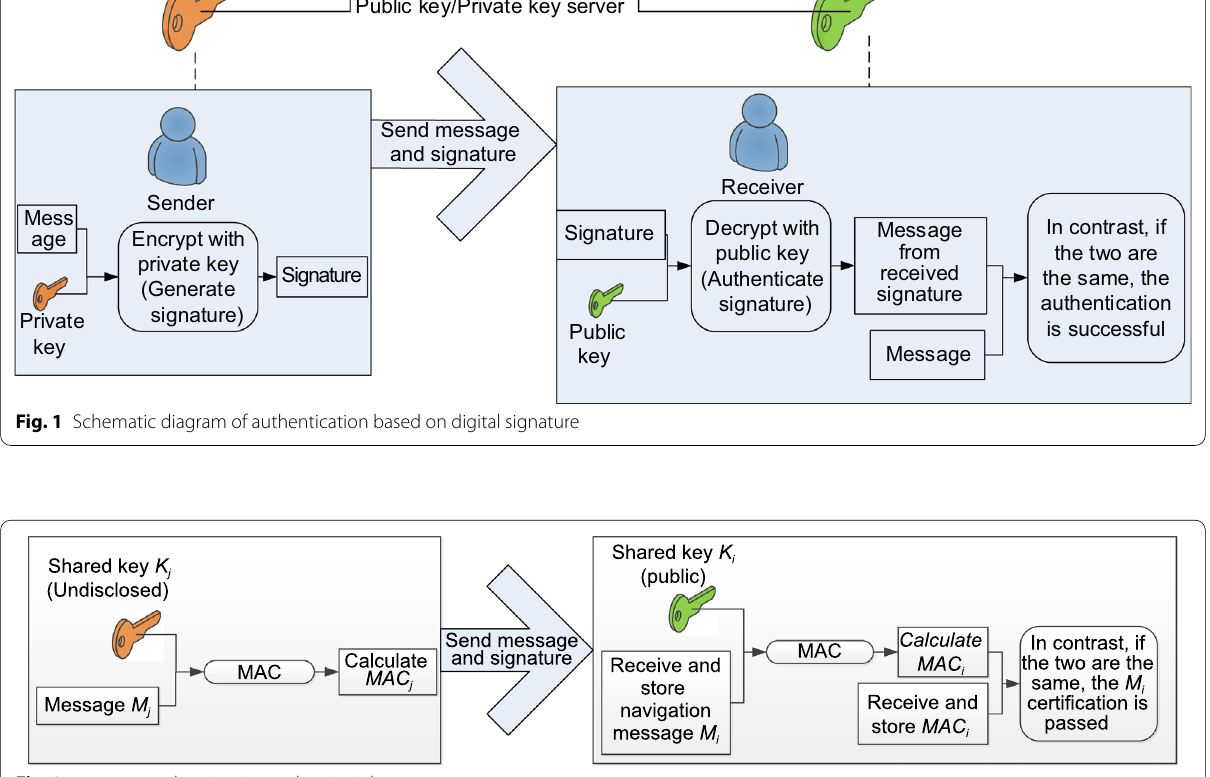
Fig. 2 message authentication code